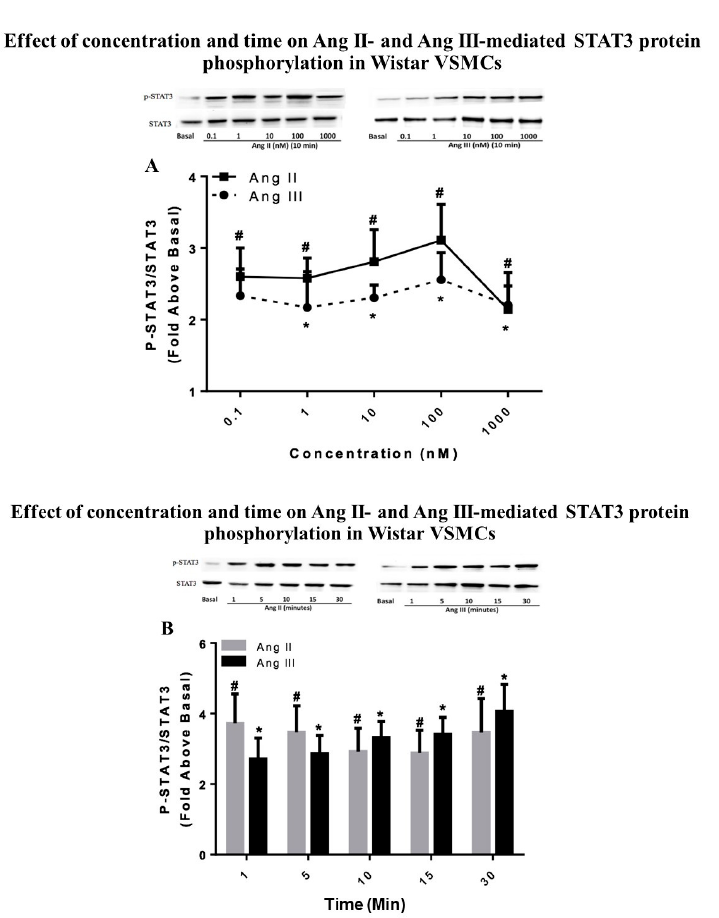
Figure 1. Effect of concentration and time on angiotensin (Ang) II- and Ang III-mediated STAT3 protein phosphorylation in Wistar vascular smooth muscle cells (VSMCs). Quiescent Wistar VSMCs were treated for ( A ) 10 min with either Ang II or Ang III at concentrations ranging from 0.1 nM to 1000 nM or ( B ) with 100 nM Ang II or 100 nM Ang III for 1 min to 30 min. Phosphorylated-STAT3 protein levels were measured by Western blot analysis using a specific antibody for the phosphorylated form of STAT3. Protein loading was visualized using the non-phosphorylated STAT3 antibody. The data were analyzed by densitometry and the amount of phosphorylation was calculated as the fold-increase above basal in the presence of vehicle. Each value represents the mean ± SEM of preparations of VSMCs isolated from at least five Wistar rats. * Denotes p < 0.05 as compared to basal levels of STAT3 expression in VSMCs for Ang III. # Denotes p < 0.05 as compared to STAT3 basal levels in VSMCs for Ang